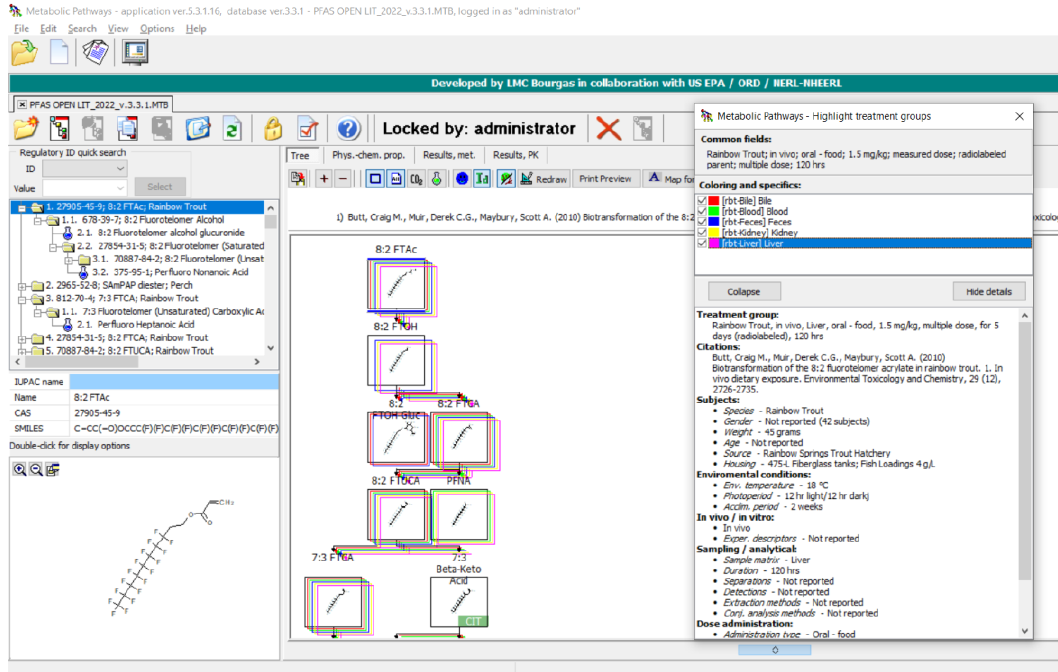
Figure 5. Highlight Treatment Group function for the in vivo study of 8:2 Fluorotelomer Acrylate (8:2 FTAc) in rainbow trout. Colored boxes around metabolites in the metabolic map are correlated to the respective treatment groups, which are bile, blood, feces, kidney, and liver, in this case.